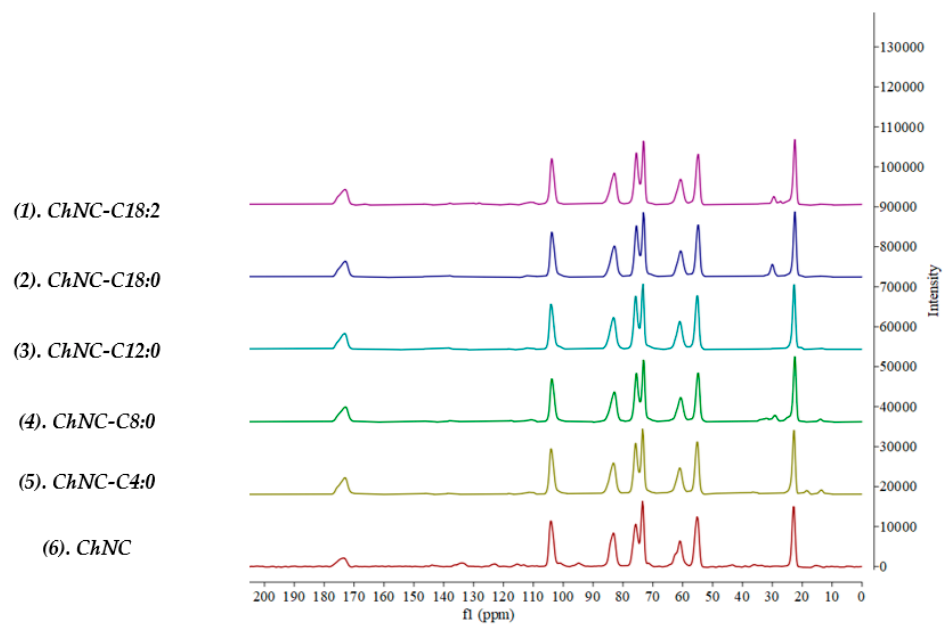
Figure A2. FTIR spectra of (1) ChNC-C18:2, (2) ChNC-18:0, (3) ChNC-C12:0, (4) ChNC-C8:0, (5) ChNC-C4:0, and (6) unmodified.